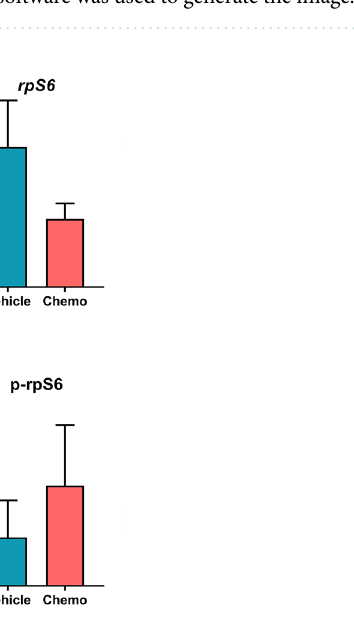
Figure 4. Validation of individual primordial follicle oocyte RNA-seq results by qRT-PCR and immunochemistry. ( A ) qRT-PCR analysis of PI3K/PTEN/Akt pathway genes shows no significant change in the expression of Akt-1 (n vehicle = 5 and n chemo = 6; p = 0.93), rPS6 (n vehicle = 5 and n chemo = 6; p = 0.32) or Foxo3a (n vehicle = 5 and n chemo = 6; p = 0.12) in the cyclophosphamide-treated group (chemo) as compared to the vehicle. The ‘n’ indicates the number of single primordial follicles analyzed, data are presented as mean of the ΔΔCt ± S.E.M. ( B ) There is no change in the percentage of primordial follicles stained for (phospho)-Akt (7.29 ± 0.22, n = 8 vs. 11.59 ± 0.8, n = 6; p = 0.52), p-Foxo3a (12.03 ± 1.48, n = 9 vs. 18.85 ± 1.43, n = 8 ; p = 0.63), and p-rpS6 (6.06 ± 0.14, n = 11 vs.12.55 ± 0.94, n = 7; p = 0.4) after cyclophosphamide treatment. The ‘n’ indicates the number of xenografted ovarian cortex tissues, data are presented as mean ±